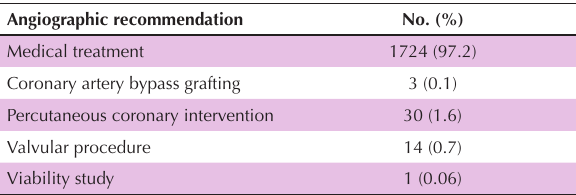
Table 3. Angiographic recommendations to patients with MINOCA Angiographic